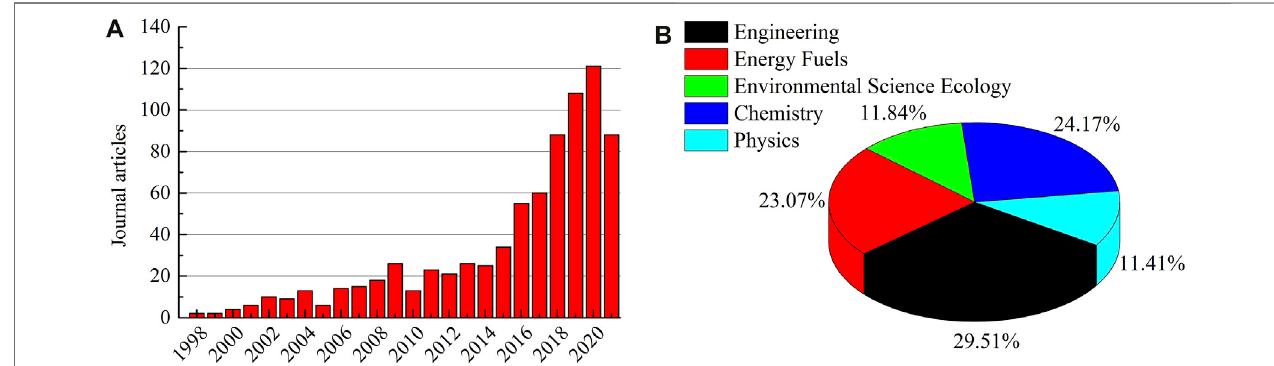
FIGURE 1 | (A) Journal articles from the Web of Science Core Collection for the application of MD to coal research and (B) the corresponding fi eld distribution.